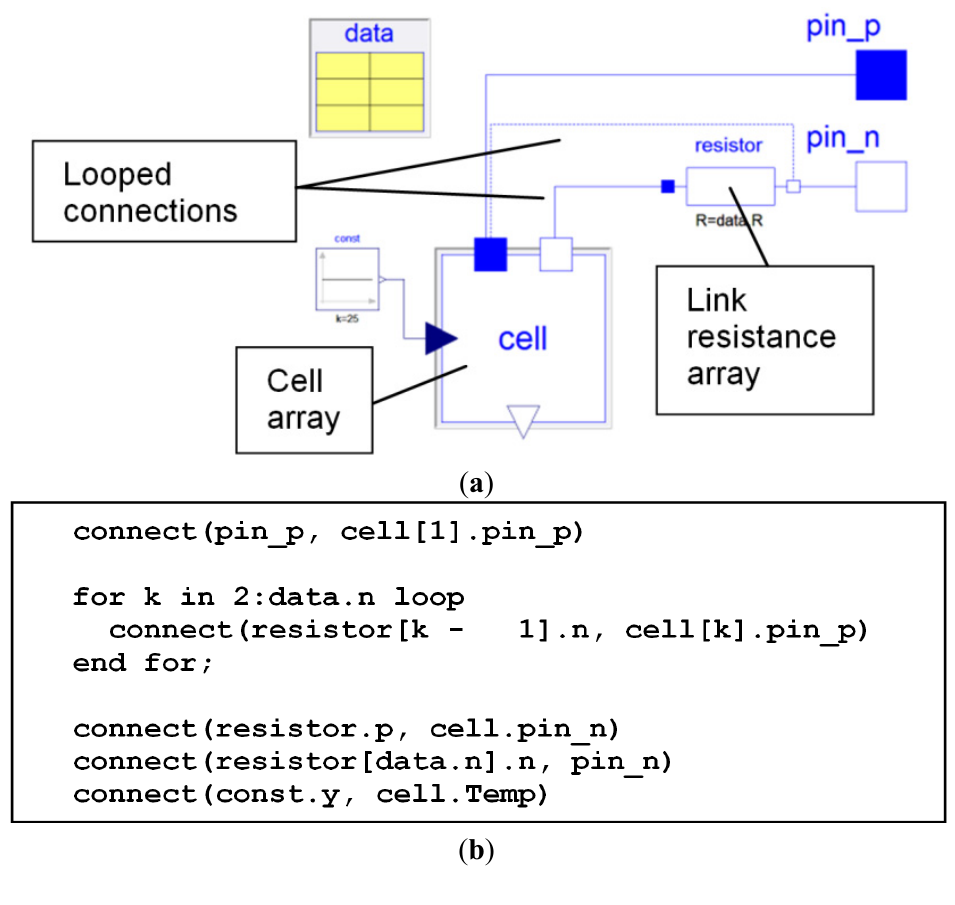
Figure 9. ( a ) Dymola model diagram layer showing component array methodology for scalable stacks; and ( b ) Dymola code extract for the cell model